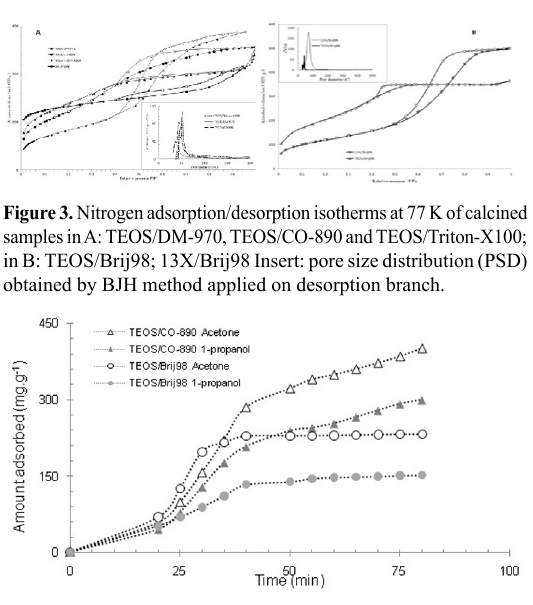
Figure 4. Adsorption breakthrough curves of acetone and 1-propanol over TEOS/CO-890 and TEOS/Brij98